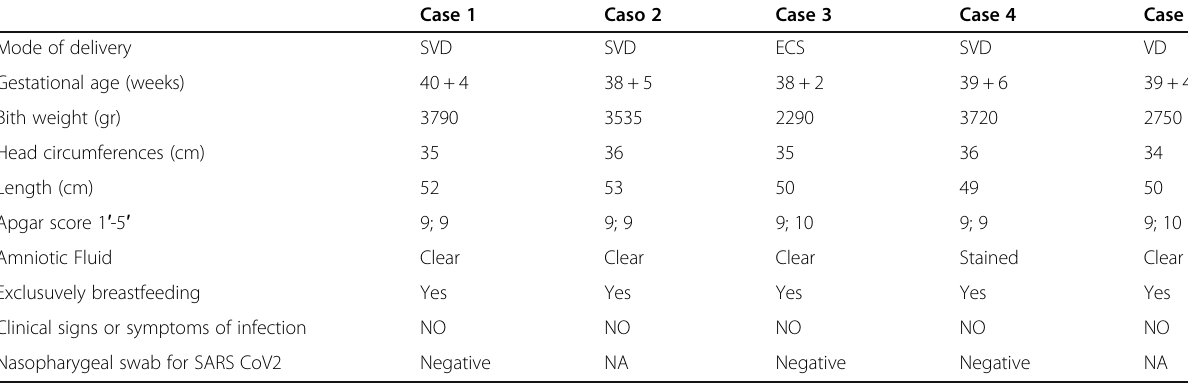
Table 2 Clinical data of